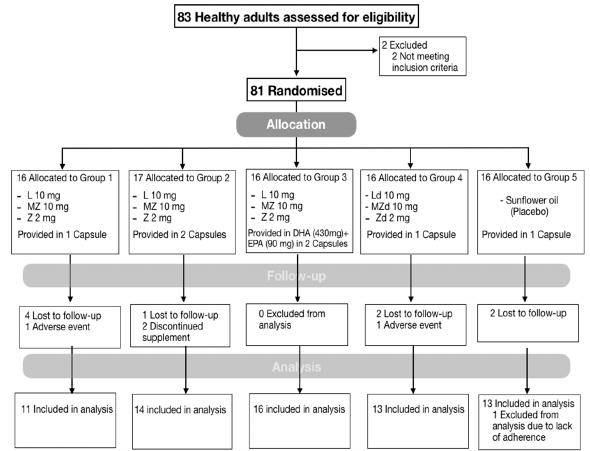
Figure 2. Screening, randomisation, and follow-up of study participants. Abbreviations: L, lutein; MZ, meso -zeaxanthin; Z, zeaxanthin. A total of 2 participants discontinued the interventions due to adverse events related to gastrointestinal symptoms, bloating and gastric discomfort when taken in a fasted state. Lost to follow-up was due to loss of contact.